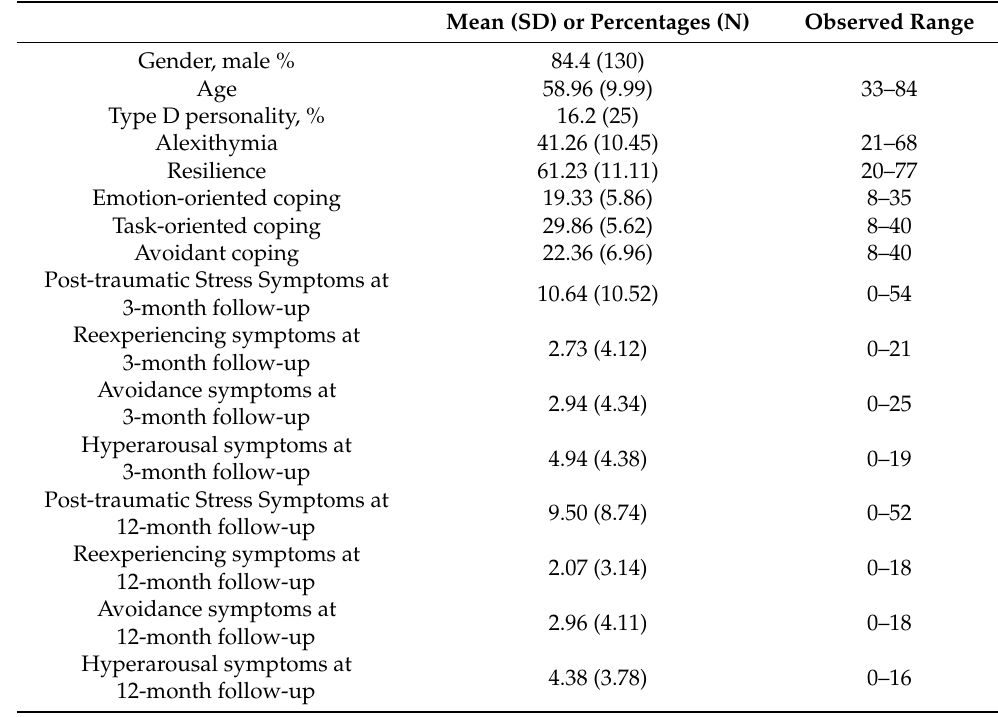
Table 1. Characteristics of the sample at 3-month follow-up ( n = 154) and at 12-month follow-up ( n = 104).